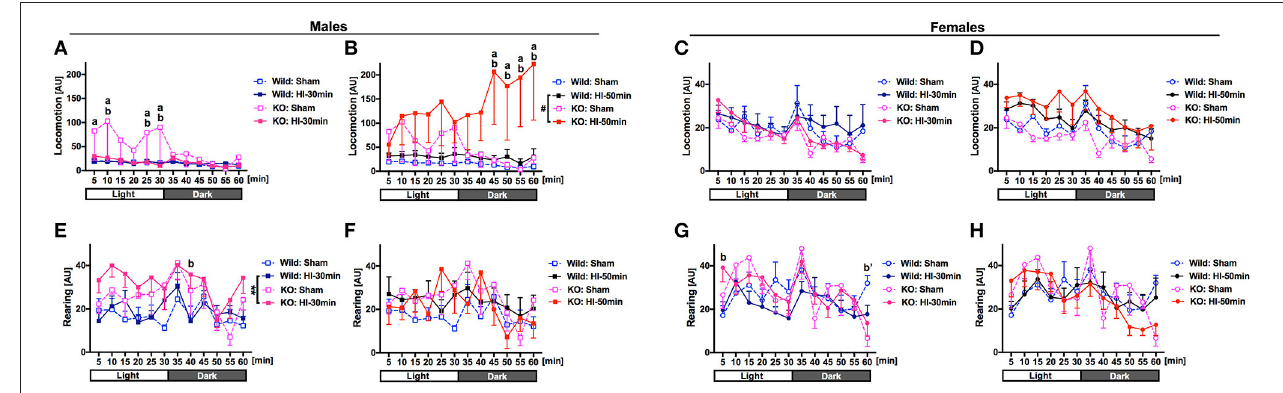
FIGURE 5 | Spontaneous activities were evaluated in open-field tests 10–13 days after surgery (P22-25). Mice were allowed to search freely in a box for 30min while in a light environment and for the next 30min while in a dark environment. The total number of times that the infrared beams set at specific intervals along the X-, Y-, and Z-banks of the box were crossed by each animal was counted and scored as “locomotion” for horizontal movement (males: A,B , females: C,D ) and as “rearing” for vertical movement (males: E,F , females: G,H ). The experiments were designed and performed in six groups, i.e., sham, HI-30min, and HI-50min groups, each containing both wild type and BMP-3b KO subgroups. To avoid the use of busy graphs with six lines, the HI-30min and HI-50min groups are presented separately, each with the same sham group. Mean ± standard error of the mean (SEM). AU, arbitrary unit. Males: Wild Sham, n = 6; Wild HI-30min, n = 9; Wild HI-50min, n = 7; BMP-3b KO Sham, n = 4; BMP-3b KO HI-30min, n = 7; BMP-3b KO HI-50min, n = 4. Females: Wild Sham, n = 7; Wild HI-30min, n = 11; Wild HI-50min, n = 7; BMP-3b KO Sham, n = 5; BMP-3b KO HI-30min, n = 9; and BMP-3b KO HI-50min, n = 13. # p = 0.08, ** p < 0.01. a: p < 0.05, KO HI vs. KO Sham. b: p < 0.05,